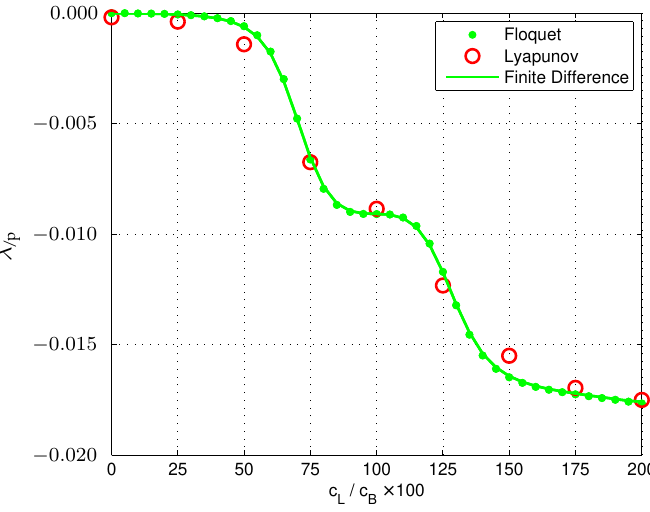
Figure 6. Sensitivity estimates of characteristic exponents from Lyapunov theory (LCEs), Floquet Analysis, and finite differences, corresponding to the lightly damped blade lag mode of Figure